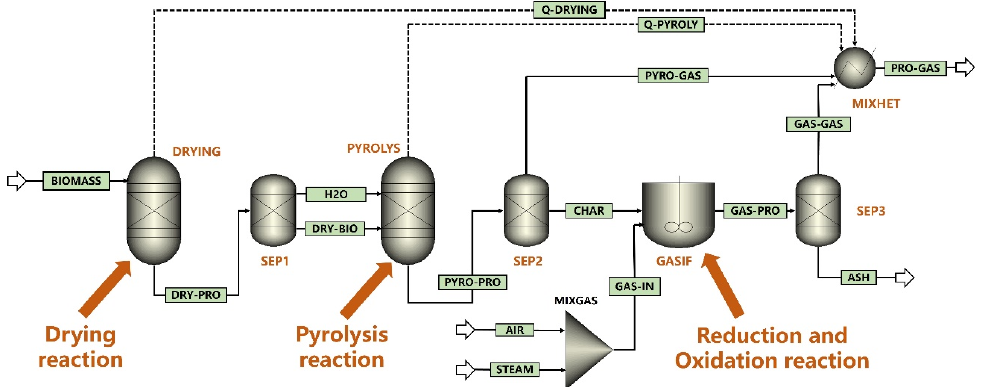
Figure 2. Schematic of Aspen Plus simulation process of improved updraft biomass gasifier.